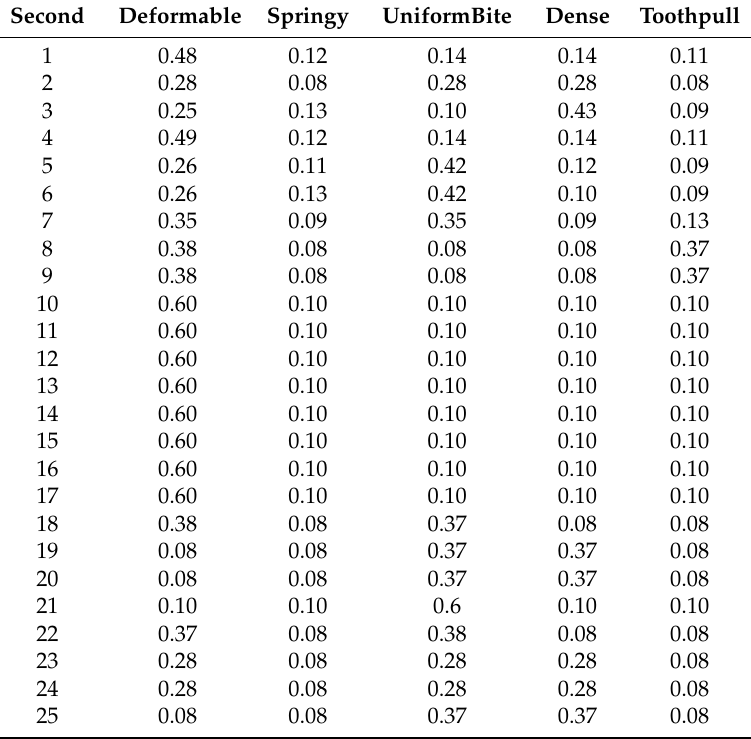
Table 3. Shapley values for each panel descriptive CATA item to Overall Liking of Texture varying with time